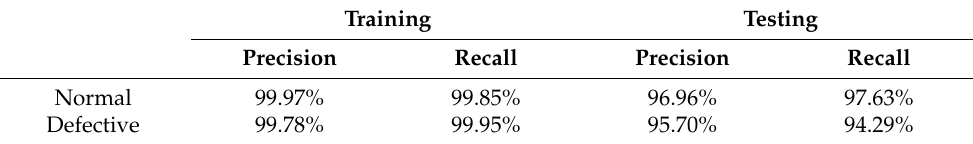
Table 5. Precision and recall